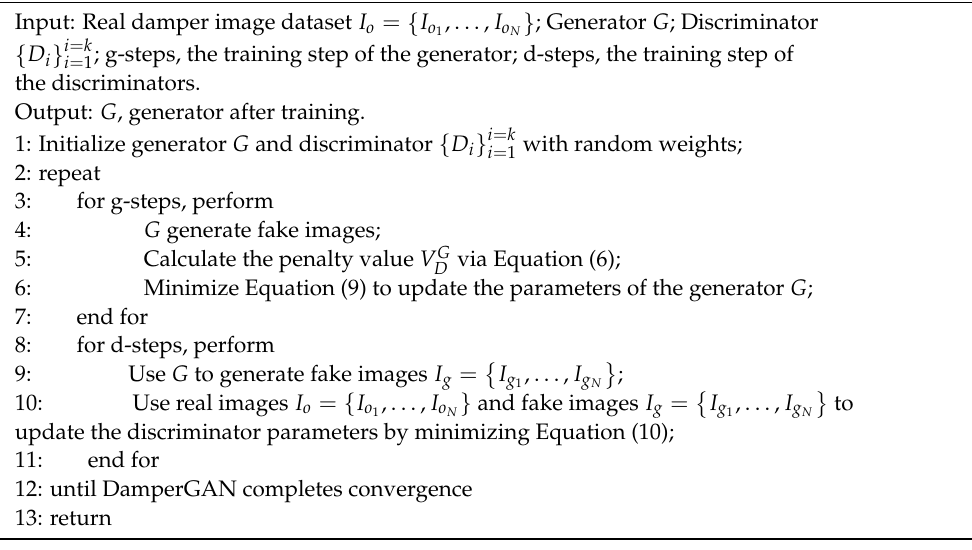
Algorithm 1. The training process of